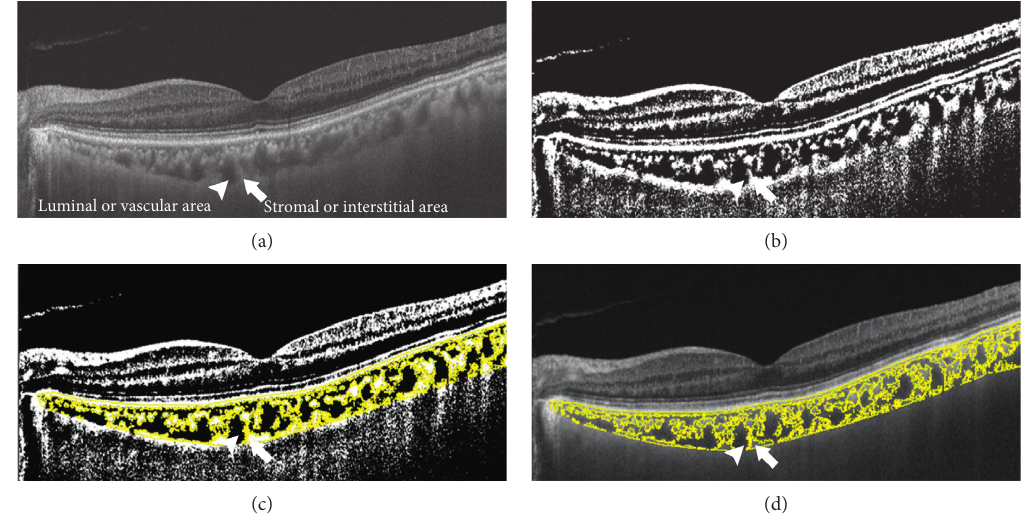
Figure 1: The dark pixels (arrow head) represented the luminal or vascular area and the light pixels (arrow) were defined as stromal or interstitial area. (a) SS-OCTscan image. (b) Image was converted with the auto local threshold tool. (c) The dark pixels were selected using the threshold tool. (d) An overlay image of ROI of the binarized segment of the choroid on SS-OCT scan.